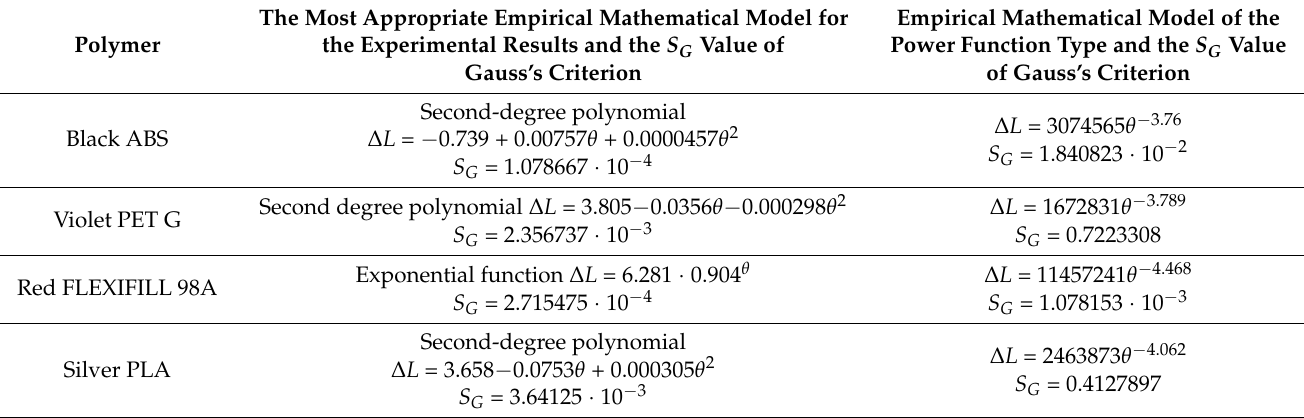
Table 5. Empirical mathematical models designed to highlight the negative thermal expansion to the temperature decrease, considering the experimental